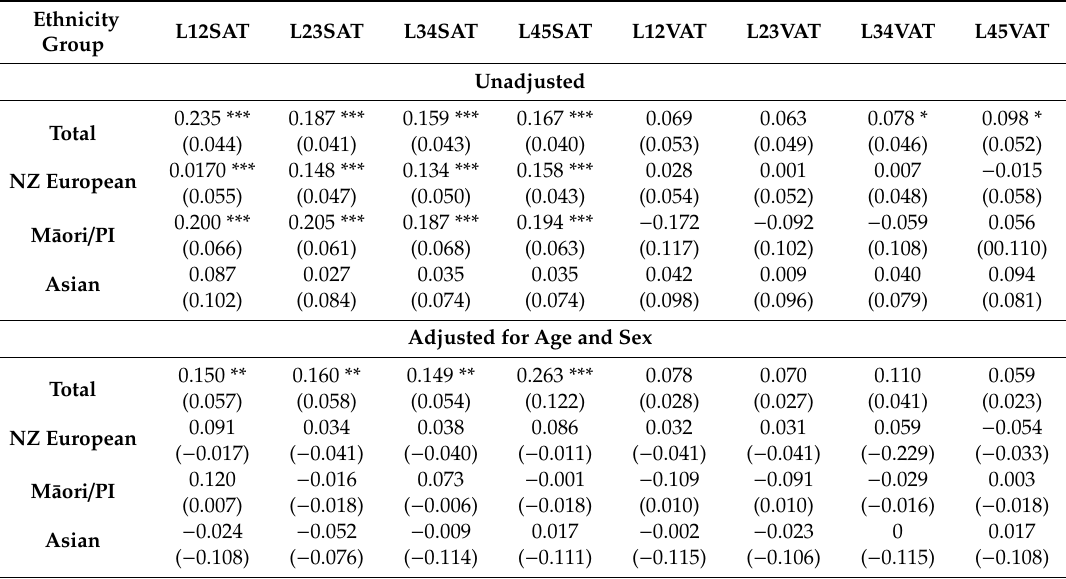
Table 5. Ethnicity-specific associations between WHtR and fat